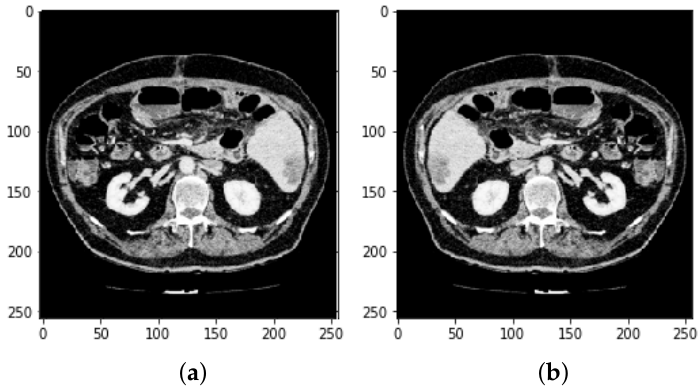
Figure 8. (Image slices a ) before reflection and ( b ) after reflection.